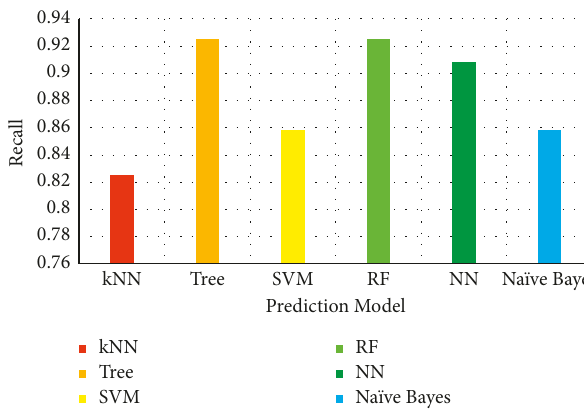
Figure 13: The recall of all ML